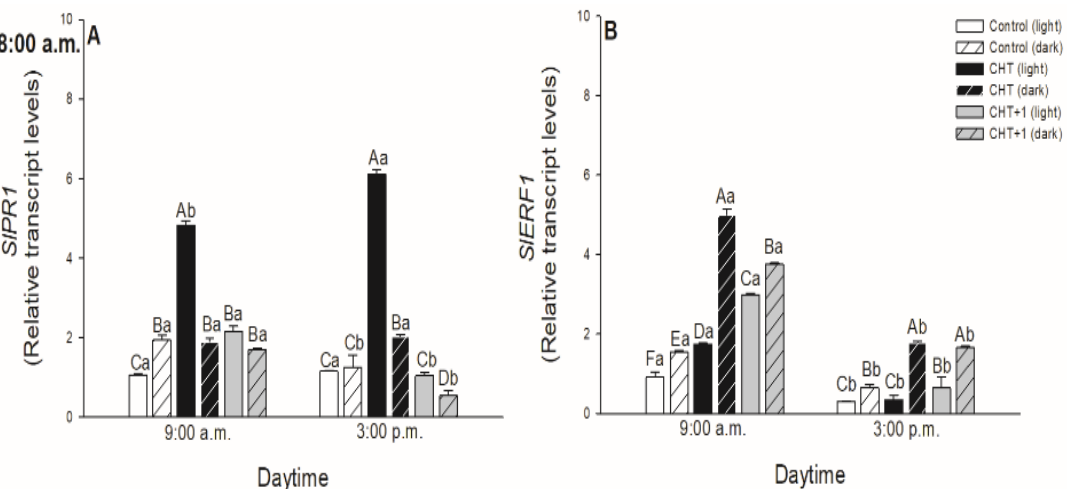
Figure 10. Changes in the relative expression levels of SlPR1 ( A ) and SlERF1 ( B ) in leaves of intact tomato plants treated foliar with 100 μg mL -1 chitosan (CHT) dissolved in the experimental buffer (1 mM AA, 10 mM MES/TRIS, 10 mM KCl, 0.1 mM CaCl 2 , pH 6.15) in the morning at 08:00 hrs, under light (normal columns) or in continuous darkness (stripped columns)]. Measurements were disposed at constant times after treatments (09:00 and 15:00 hrs). Means ± SE, n = 3. Means were analyzed by two-way ANOVA, significant differences among the data were analyzed by Holm-Sidak test. Mean values significantly different at P < 0.05 were signed with different letters, upper case letters indicate the effects of the treatment at the same daytime, and lower case letters indicate the effects of the daytime under the same treatment. (Control: treatment with 1 mM Acetic acid buffer (AA); CHT: treatment with 100 μg mL –1 chitosan in experimental buffer containing AA; CHT+1: untreated distal leaf level from the CHT-treated one).